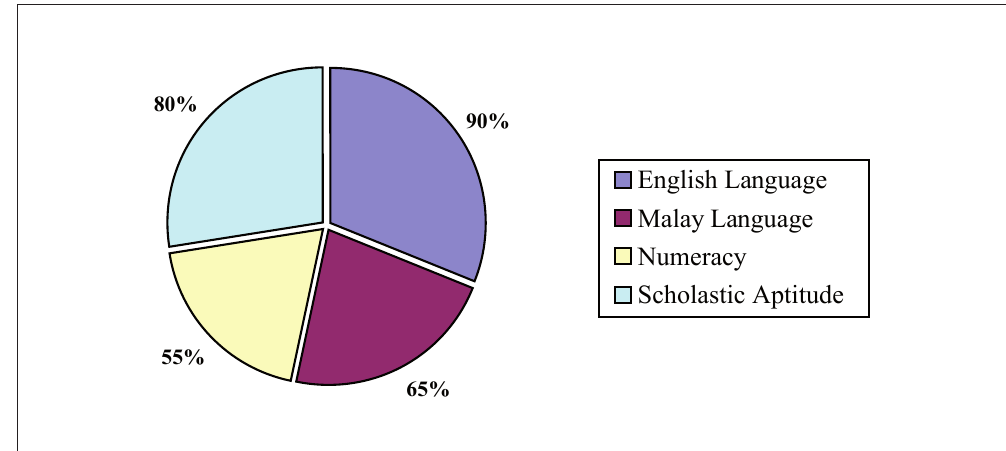
Figure 8 Performance of students in each component of the Diagnostic Test